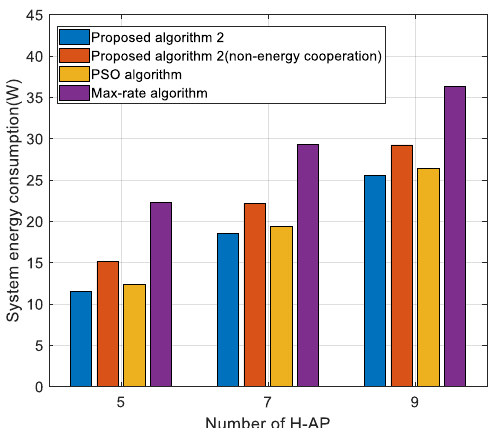
Figure 4. System energy consumption versus the number of H-APs for different algorithms.